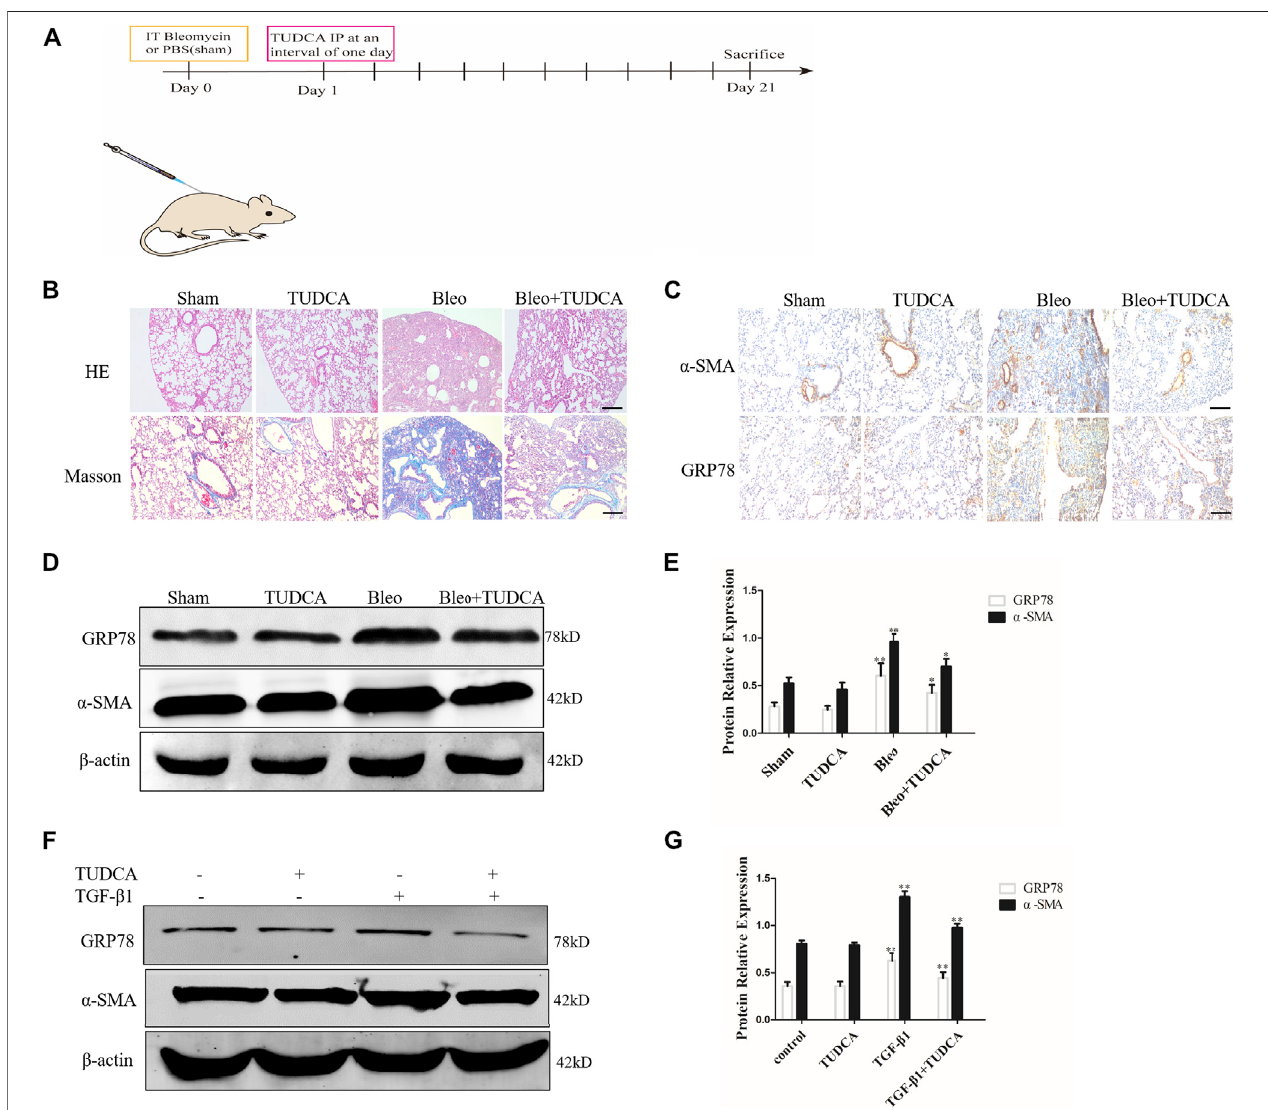
FIGURE 3 | ER stress in the lung fi broblasts is critical for pulmonary fi brosis progression. (A) . Experimental scheme of the mouse model of bleomycin-induced pulmonary fi brosis. Mice were intratracheally injected with saline or bleomycin (3 mg/kg) at day 0. On day 1, mice were administrated with TUDCA (50 mg/kg) or DMSO by intraperitoneal injection every 2 days. Mice were sacri fi ced on day 21 ( n (cid:1) 10 for each group). (B) . Histological images and collagen deposition of the lung tissue was detected by H&E and Masson staining. Scale bar (cid:1) 100 μ m. (C) . Representative images showing GRP78 and α -SMA staining of lung tissues of mice treated with saline, bleomycin without or with TUDCA. Scale bar (cid:1) 100 μ m. (D,E) , Western blot analysis of expression of GRP78 and α -SMA. (F,G) , IMR90 were pre-treated with TUDCA(100 μ M)for2 handfollowedbyTGF- β 1(10 ng/ml)for24 h.TheexpressionlevelsofGRP78and α -SMAwasmeasuredbywesternblot. β -actinwasusedasan internal control. * p < 0.05, ** p <